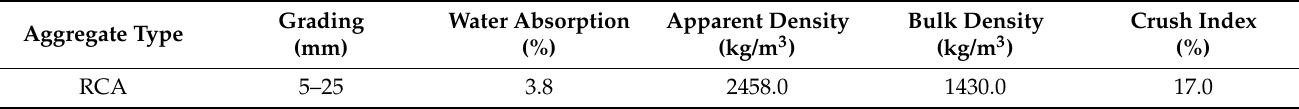
Table 2. The basic properties indexes of recycled concrete aggregate (RCA).